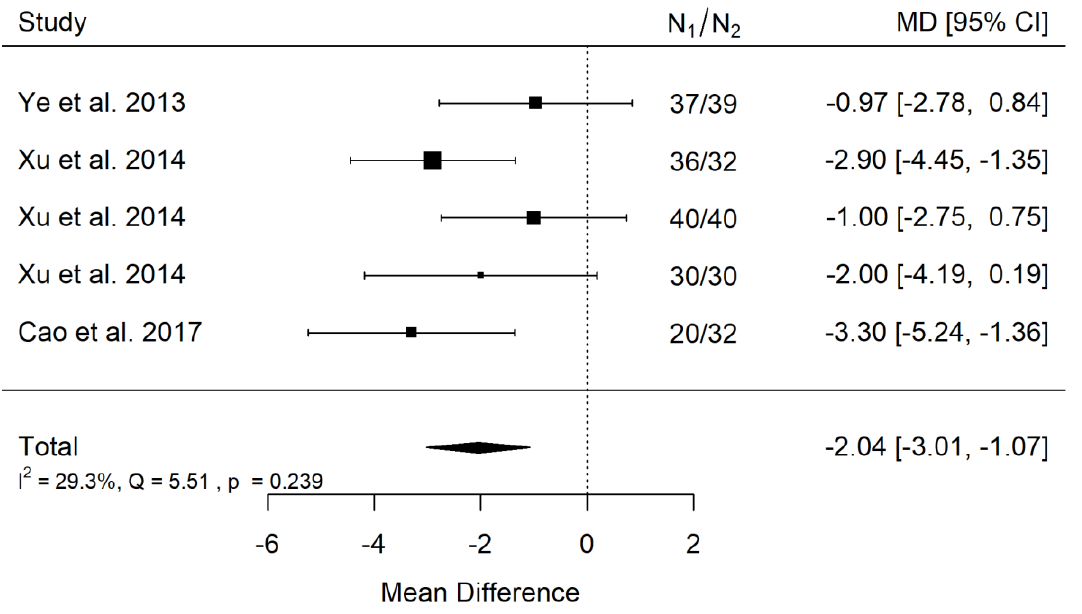
Figure 2. Forest plot of SNA values for the comparison of patients with untreated cleft palate only vs. non-cleft healthy population [18,34,35].